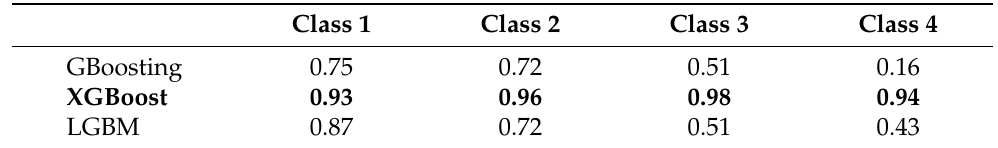
Table 4. Comparison of regressors algorithms using ( R 2 ) as the evaluation metric. This table shows that the XGBoost algorithm is the one that best predicts the number of copies of books for each of the segmentations obtained with segmentation by quartiles.